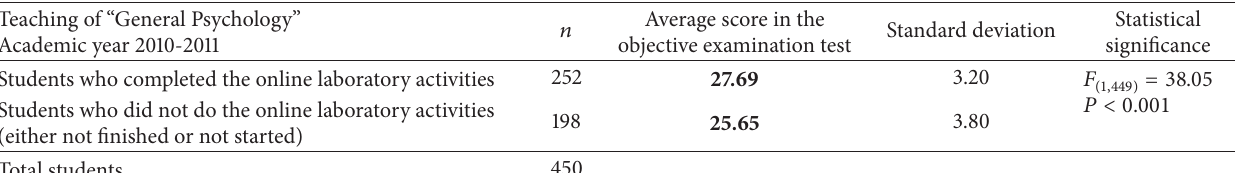
Table 2: Average results obtained in the objective examination test by students who completed the online laboratory activities versus those who did